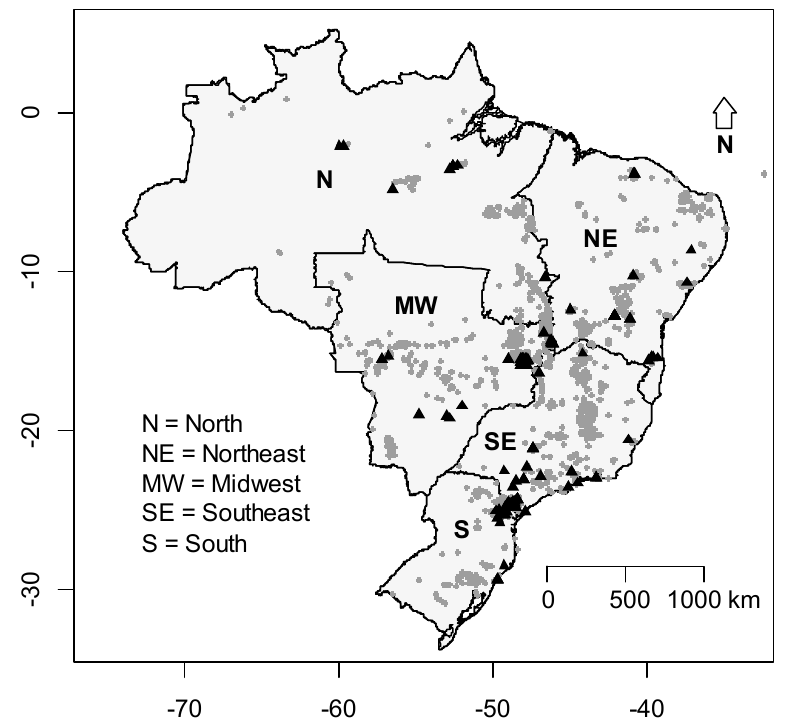
Figure 7. Distribution of Brazilian caves. Black triangles represent the caves that had already been sampled for bats and the grey circles represent the caves registered for Brazil, including one cave in the island of Fernando de Noronha.